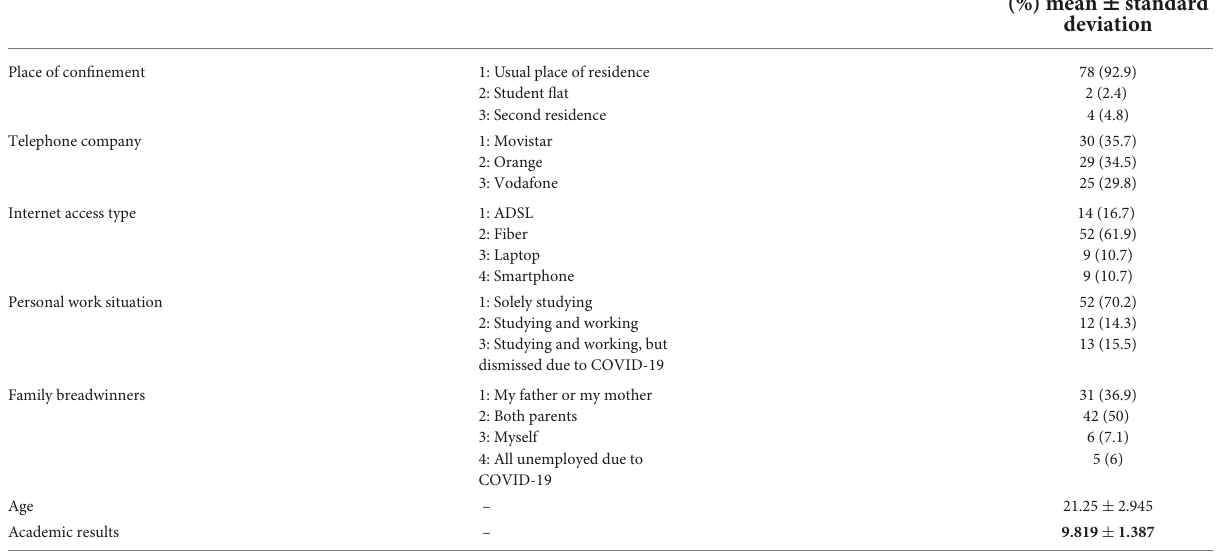
TABLE 1 Measures of association and difference between categories for the study variables and academic results. Categories